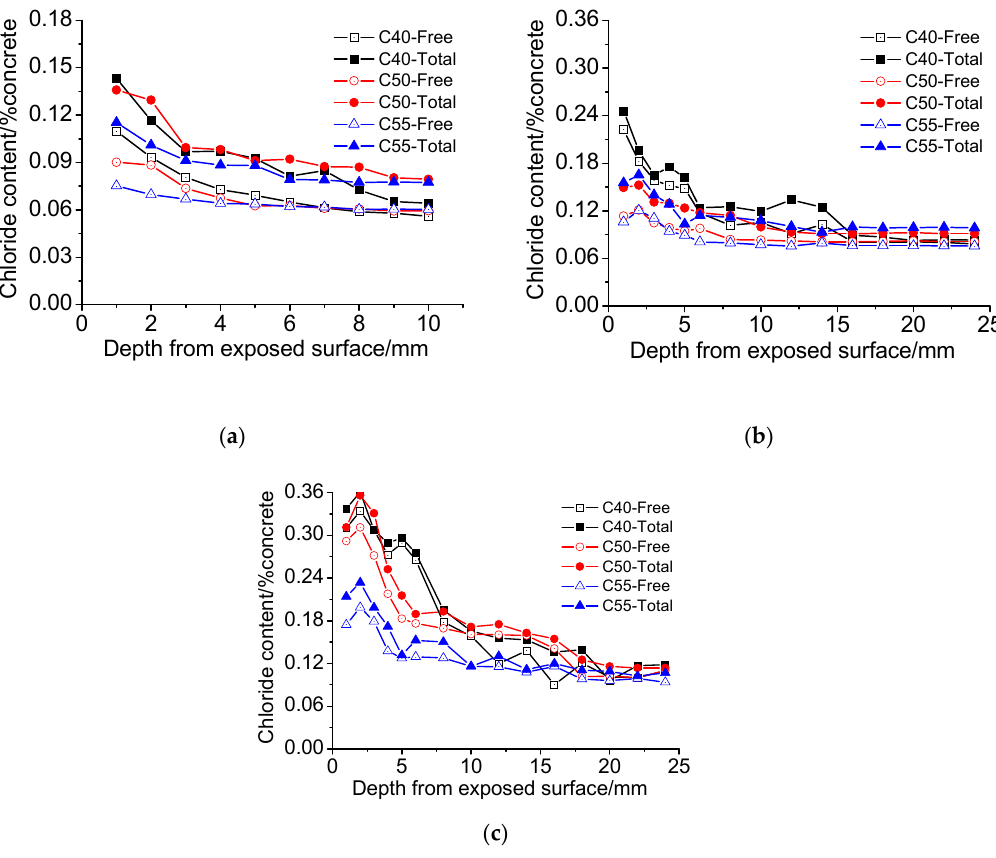
Figure 8. Chloride distribution of C40, C50, and C55 exposed to the atmosphere zone after different times. ( a ) 1 month. ( b ) 3 months. ( c ) 9 months.